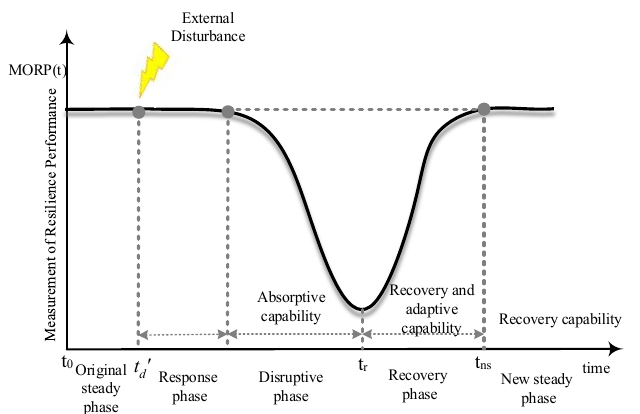
Figure 1. Schematic diagram of system resilience.